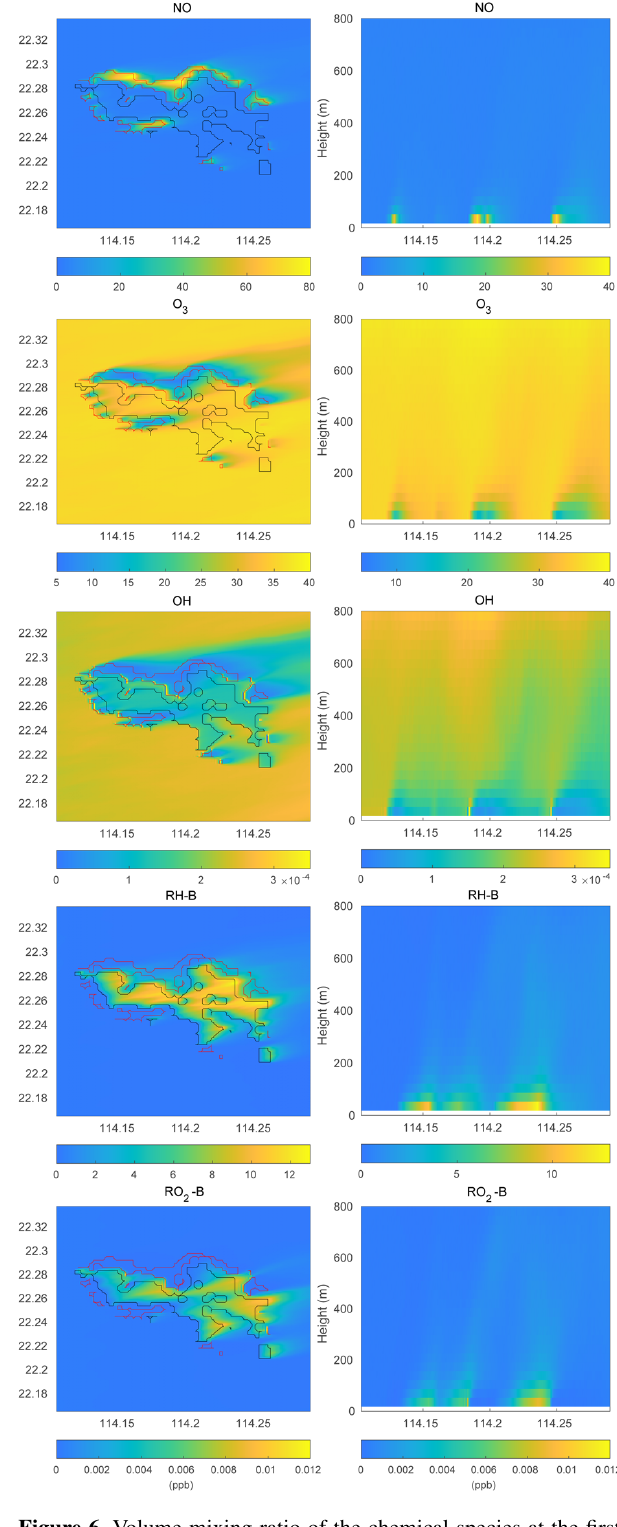
Figure 6. Volume mixing ratio of the chemical species at the first level (left panels) and vertical cross section along latitude 22.275 ◦ N (right panels) at hour 4 for the HETF case. The red line shows the urban area, and the black line shows the forest